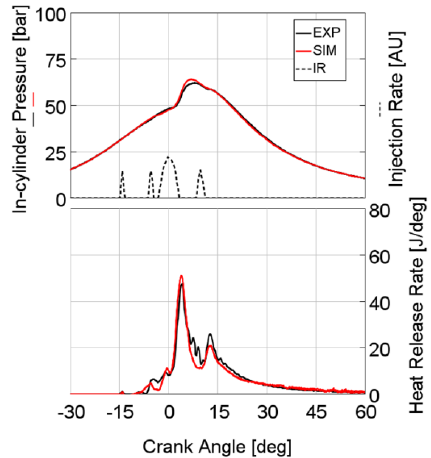
Figure 8. Top: simulated (red) vs experimental (black) in-cylinder pressure, injection rate (dashed black). Bottom: simulated (red) vs experimental (black) Heat Release Rate. WP: 1500 rpm × 5.0 bar BMEP.